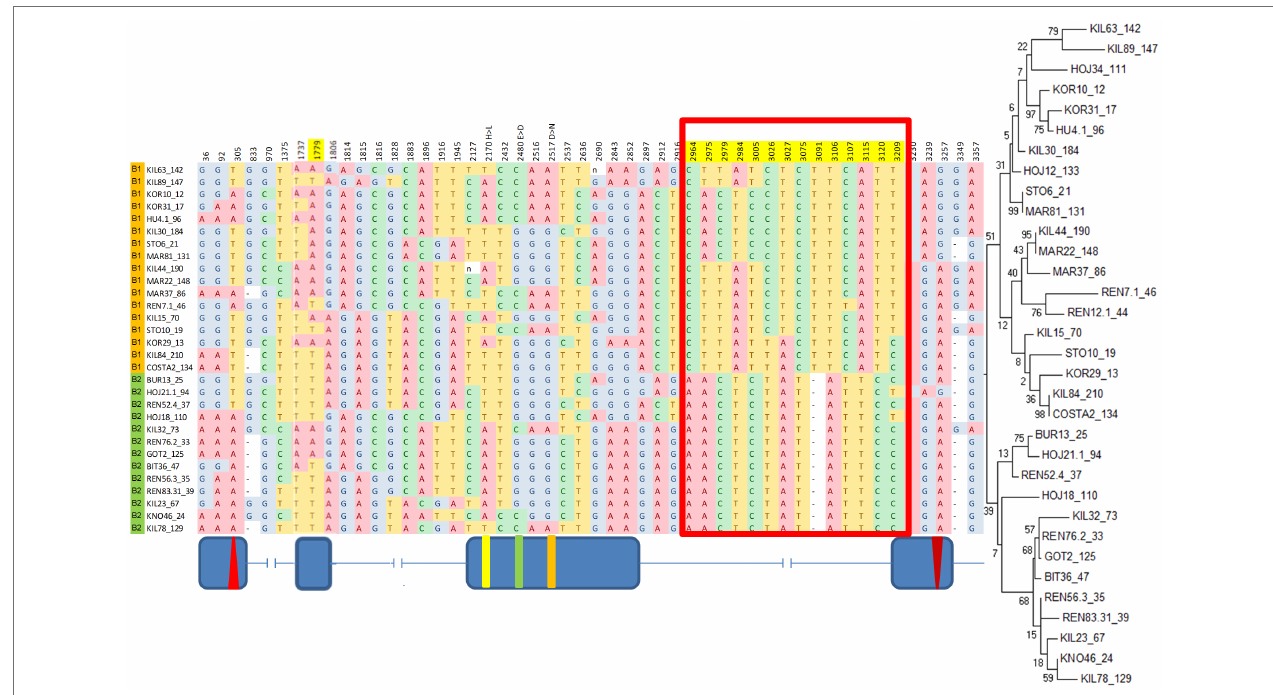
FIGURE 3 | B1/B2 haplogroups revealed by a maximum-likelihood gene tree of cry . Red boxes indicate the polymorphism underlying the two clusters in the phylogenetic tree. Fly strains are listed according to their gene tree position. Top branches: haplogroup B1 (orange); Bottom branches: haplogroup B2, (green). Position 3,091 represents a 12 bp indel (truncated for clarity). Shown are polymorphic sites with minor allele frequency >30%. The maximum-likelihood gene tree is shown on the right. Schematic diagram (not to scale) indicating the exon–intron is shown